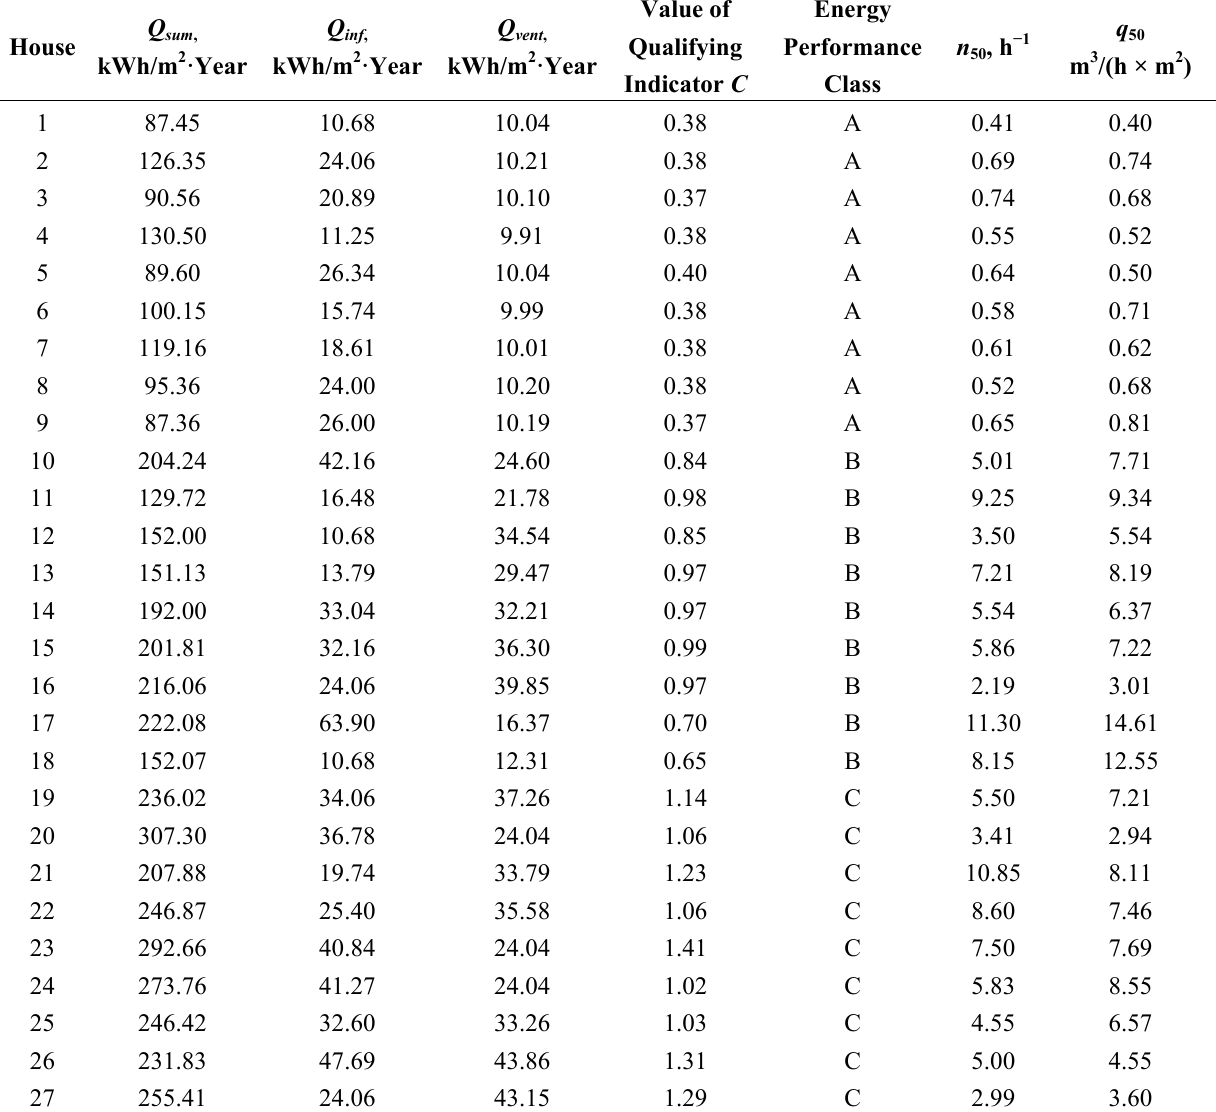
Table 2. Calculated sum energy consumption for investigated buildings, energy consumption due to over norm infiltration through windows and external doors, energy consumption for ventilation, values of qualifying indicator C, determined energy performance classes, results of measured average air exchange rates per hour at 50 Pa pressure, and the air leakage rate of building